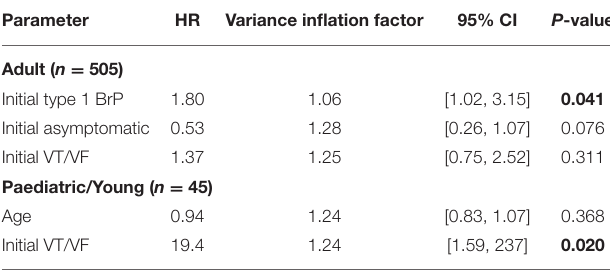
TABLE 2A | Multivariate Predictors for post-diagnosis VT/VF-free survival in BrS excluding baseline ECG parameters. Parameter